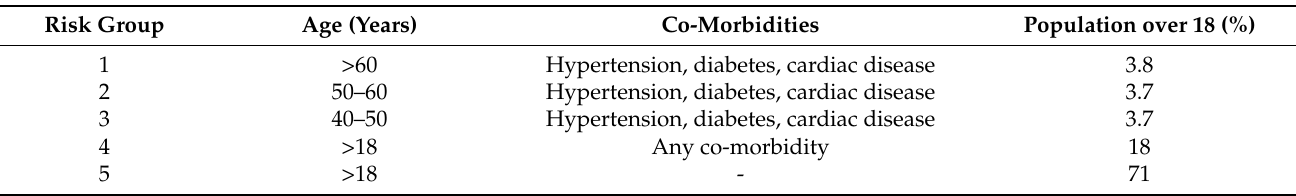
Table 1. Vaccine target population classification based on risk, as derived from the smart algorithm. Source: Gauteng Office of the Premier